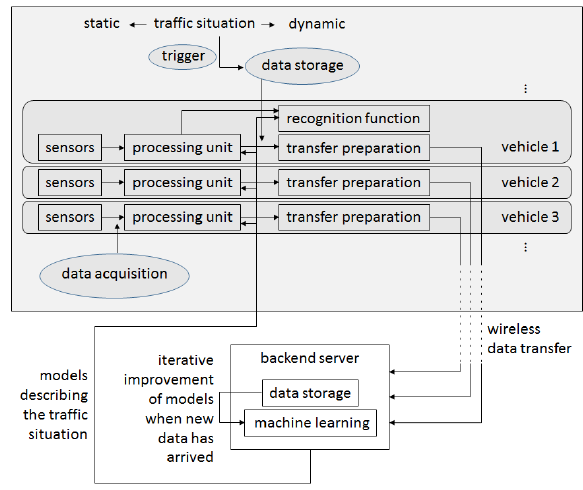
Figure 3: Process flow of the client-server system for image based recognition of dynamic traffic